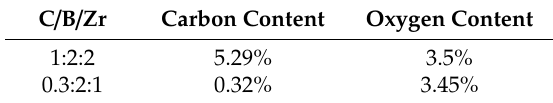
Table 3. Carbon and oxygen contents with different mole ratio of C/B/Zr.